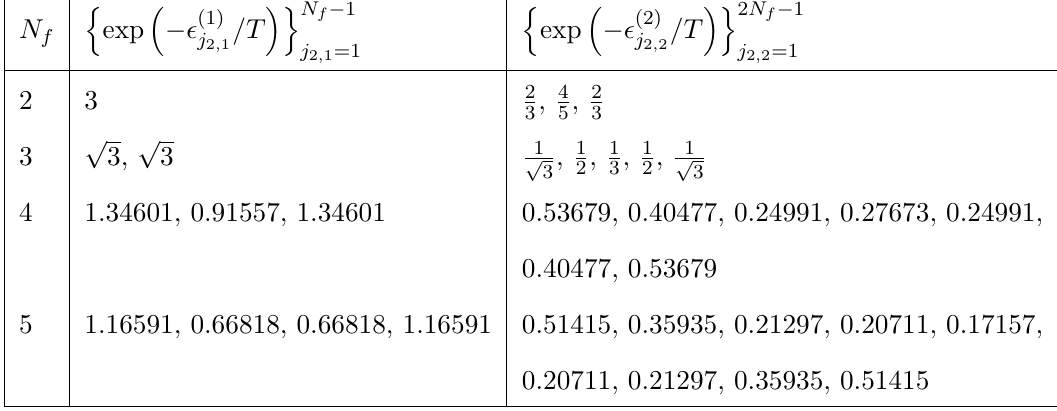
=T (cid:17) (cid:15) ( m ) ( (cid:21) ! 1 ) =T ) for j 2 ;m j 2 ;m =T = 1 j 0 ;m